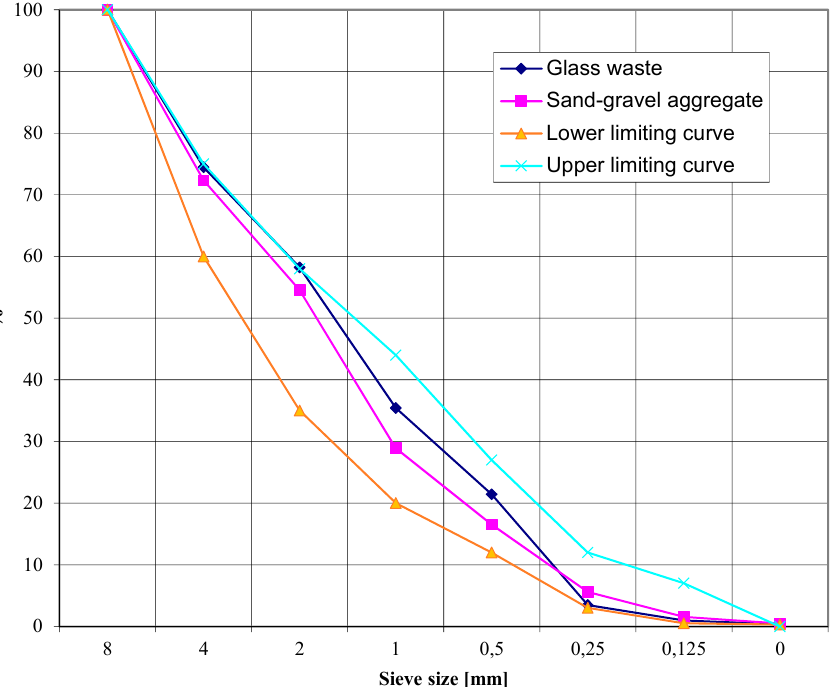
Figure 2. The sifting curves for glass aggregate and sand–gravel mixture against the background of boundary curves.